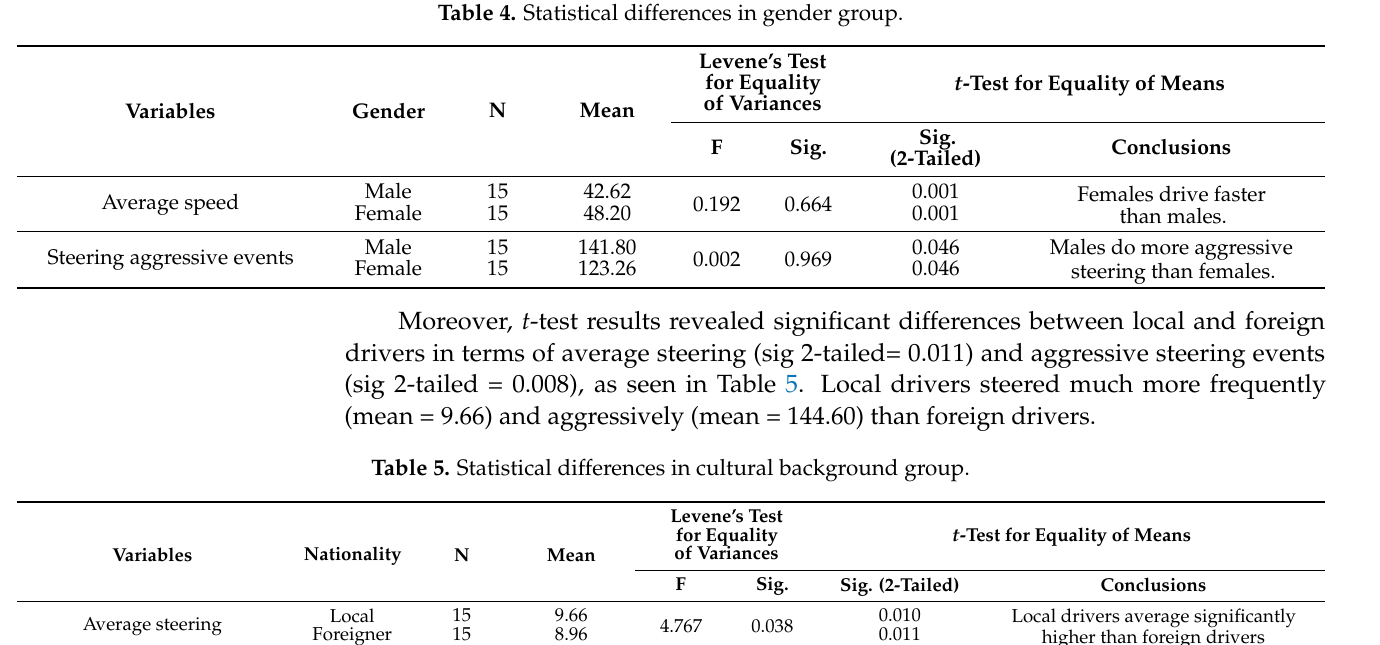
Table 6. Drivers drove faster on weekends (mean = 49.72) than on weekdays (mean =